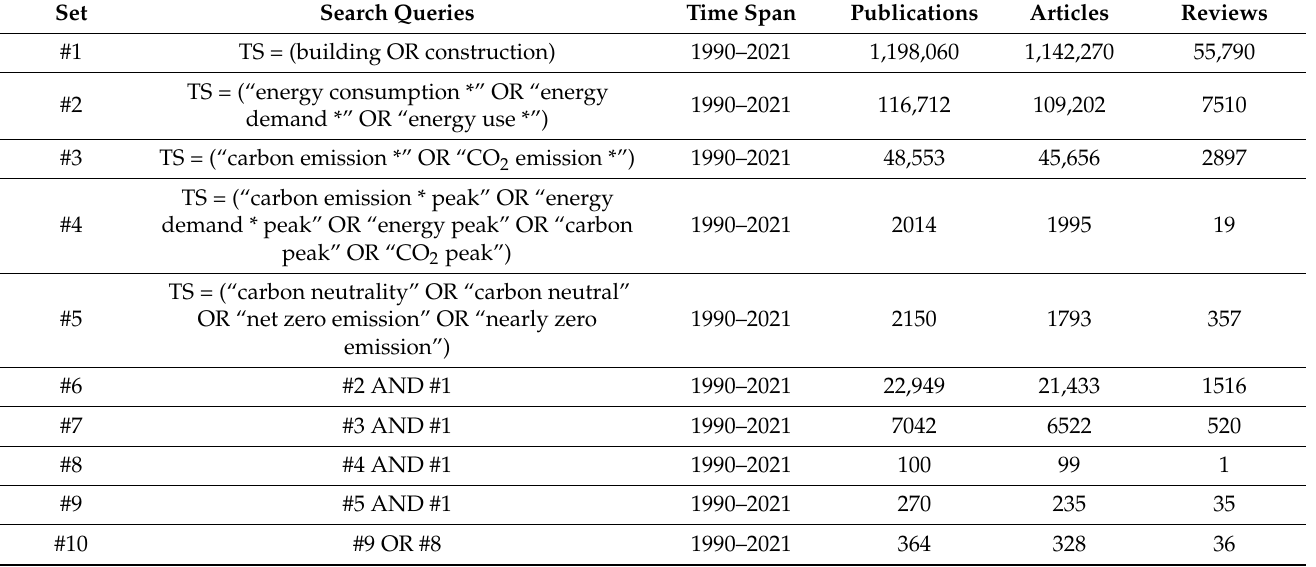
Table 1. Topic search queries used for data